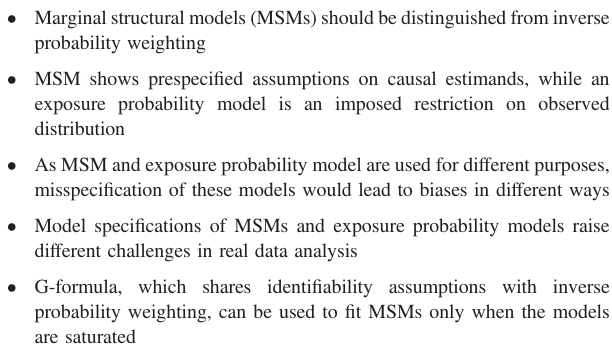
di ff erent challenges in real data